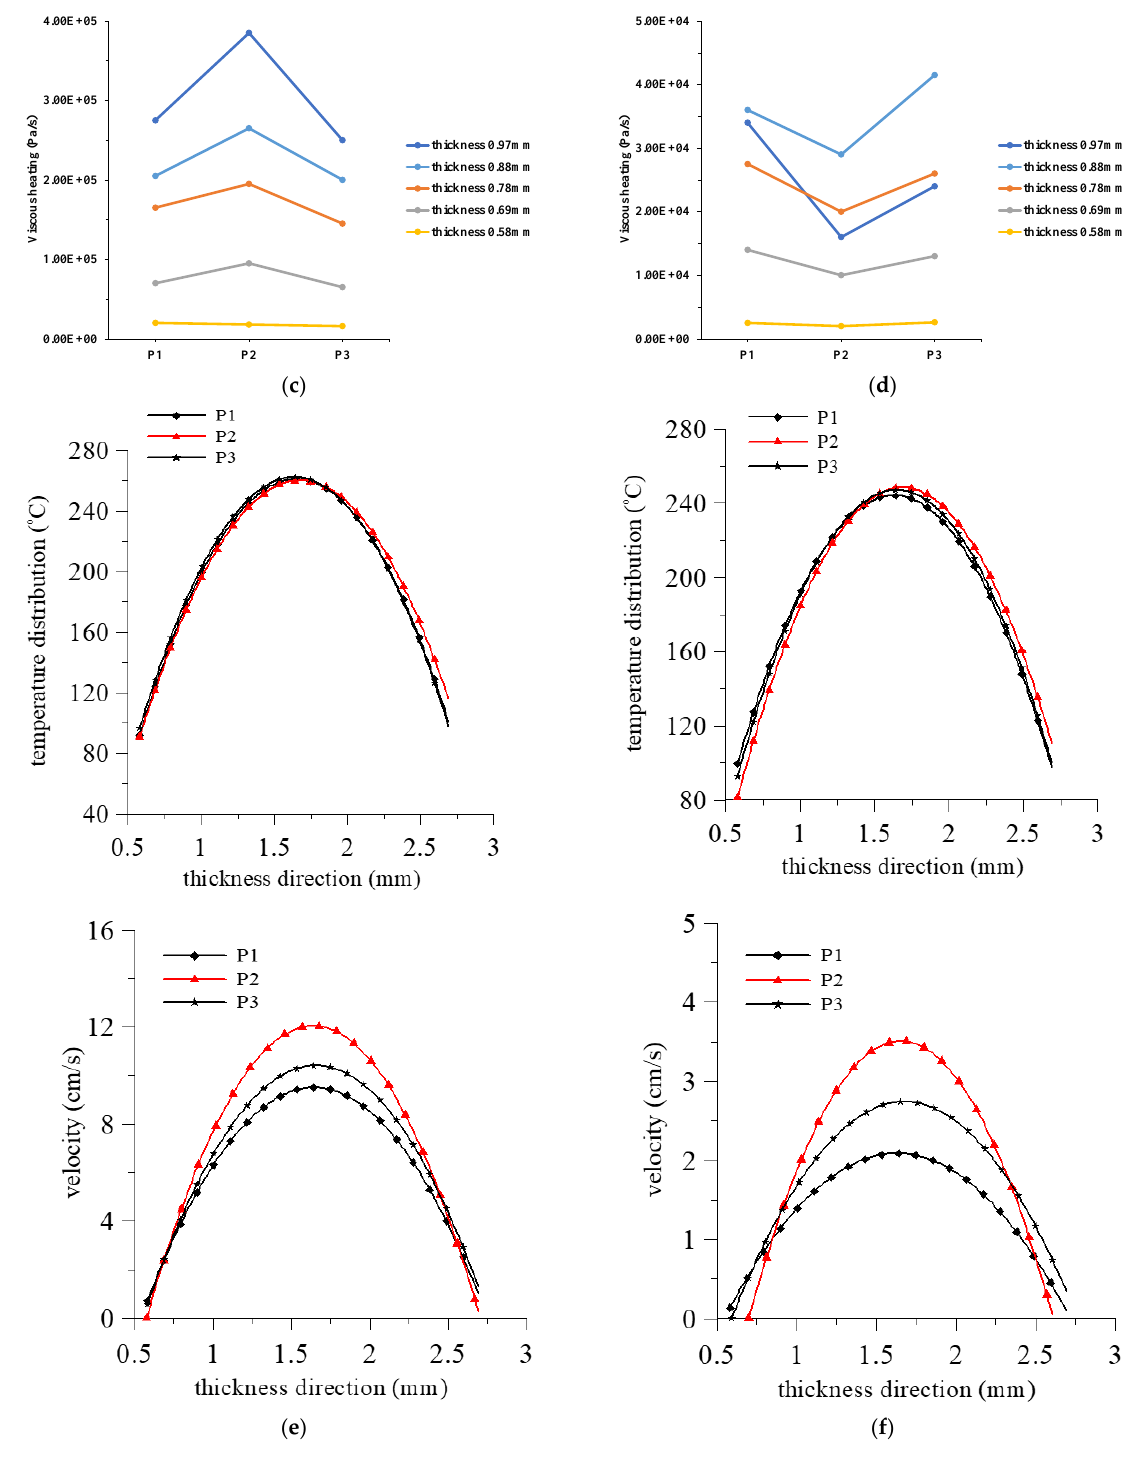
Figure 7. Viscous heating, temperature, and velocity distribution for different positions at 30% filling phage. ( a ) Viscous heating at P1, P2, P3 (melt front uniformity), ( b ) viscous heating at P1, P2, P3 (melt front hysteresis), ( c ) viscous heating at P1, P2, P3 (melt front uniformity), ( d ) viscous heating at P1, P2, P3 (melt front hysteresis), ( e ) temperature and velocity distribution at P1, P2, P3 (melt front uniformity), ( f ) temperature and velocity distribution at P1, P2, P3 (melt front hysteresis). The authors analyzed the flow characteristics in the central region of the mold cavity (discussion points P4–P6 in Figure 5) during the filling phase of MIM. The right